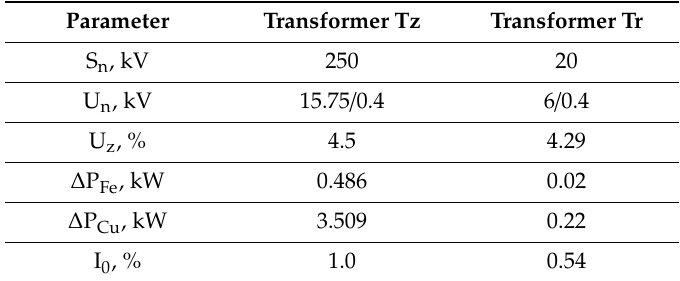
Table 1. Rated parameters of Tz and Tr transformers (Figure 3).